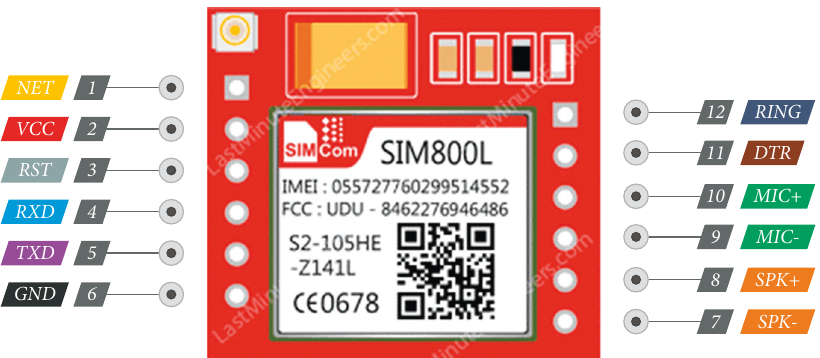
Figure 6: Sim800L GSM module pinout (as adopted from https://components101.com/wireless/sim800l-gsm-module-pinout-datasheet- equivalent-circuit-specs).